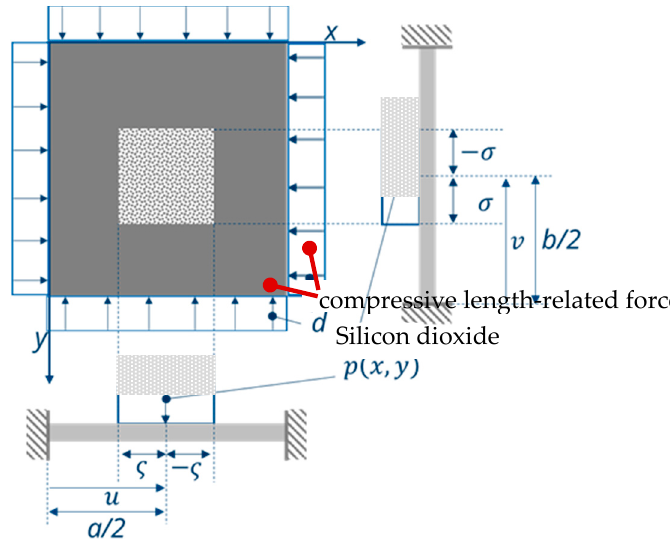
Figure 9. Fully clamped rectangular bending plate (grey) with structured silicon dioxide (SiO 2 ) layer (light grey).